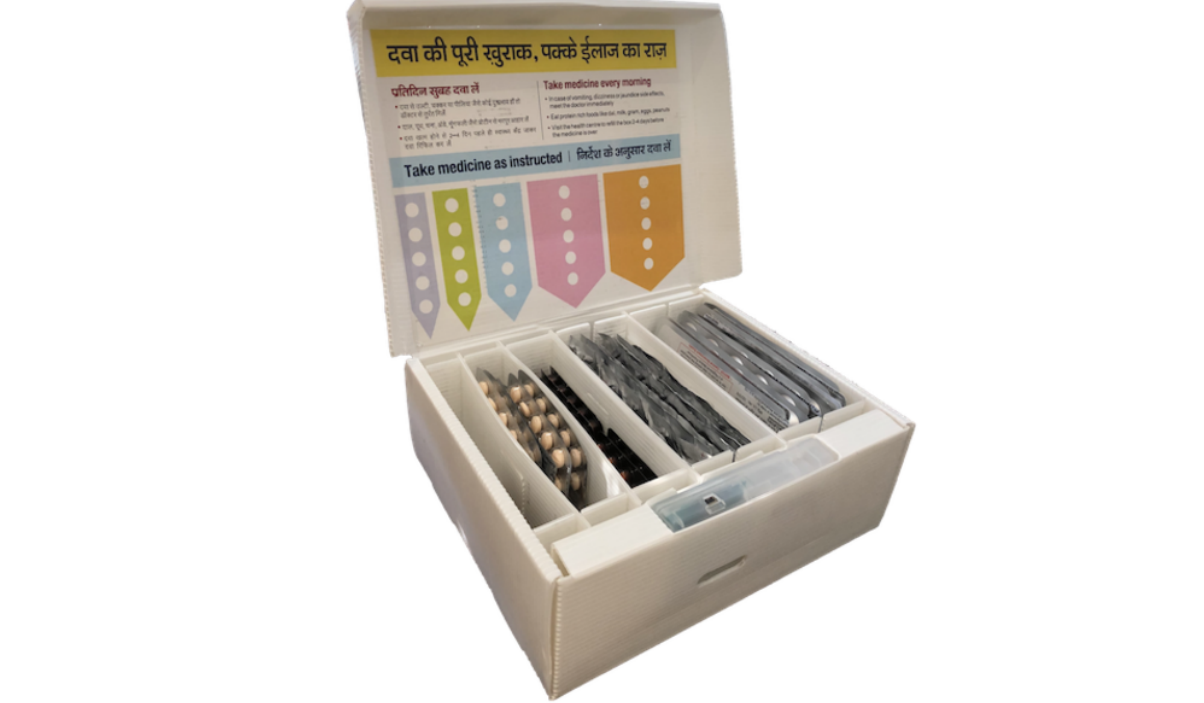
Figure 1. The Medication Event and Reminder Monitor in a cardboard version used for the initial rollout among patients with multidrug-resistant tuberculosis in India. The device includes partitions for organizing medications, medication labels inside the box lid, and a digital module that provides reminders and captures adherence data. This cardboard version was provided by Wisepill